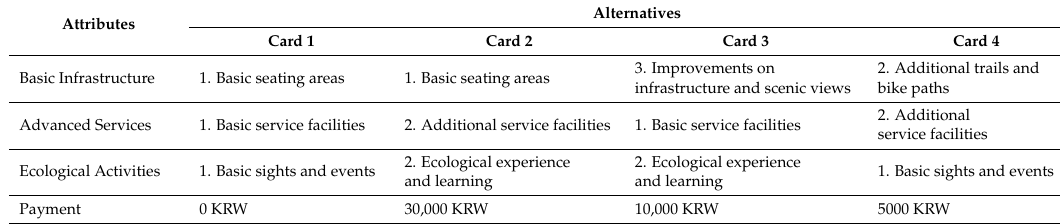
Table 3. Example of a randomly selected choice